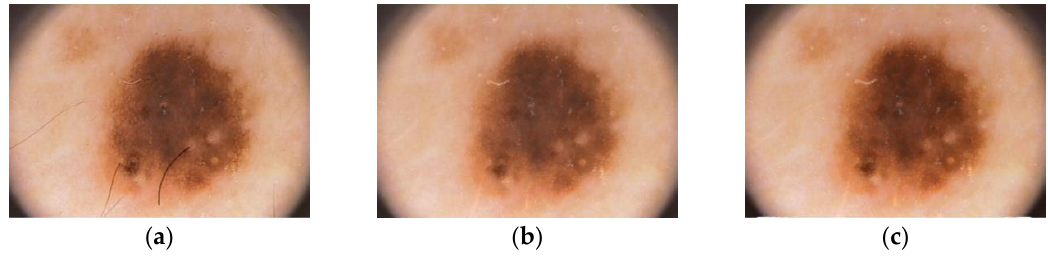
Figure 4. Skin lesion pre-processing method. ( a ) Input image IMD002, ( b ) hair removal by DullRazor algorithm, ( c ) enhanced image.